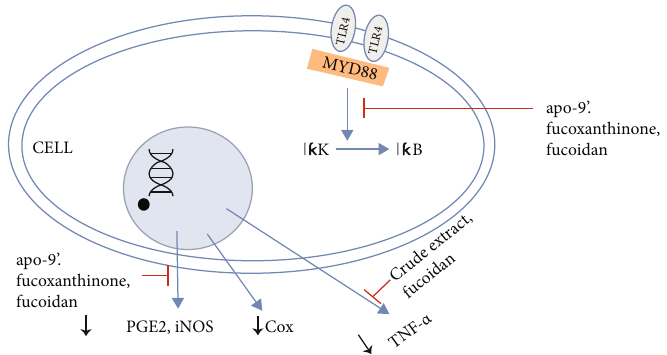
Figure 5: Anti-in fl ammatory activity mechanism of algal